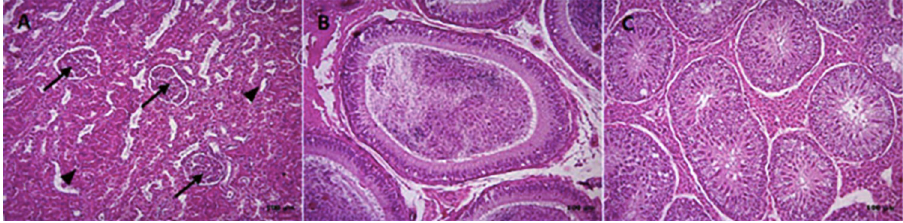
Fig 1. Histopathology of the boar organs. (A) Histology of the kidney presenting normal glomeruli (arrows) and tubules (arrowheads), showing no sign of inflammation. (B) Normal histology of the epididymis, exhibiting abundant spermatozoa in the lumen (arrow). (C) Normal histology of the testicle, physiological development of cell populations and normal architecture are maintained. No signs of inflammation are evident.